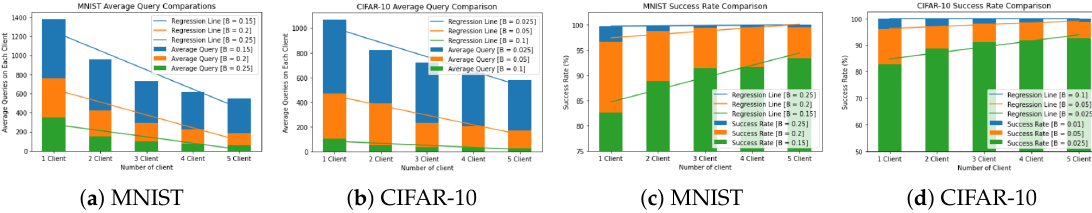
Figure 6. Distributed Approach and Constrained Boundary Evaluation. X -axis for all graphs are number of client. Y -axis for ( a ),( b ) are required average queries, while ( c ),( d ) are the success rate. For MNIST, the blue, orange, and green bars are the results when the constrained boundary is set to 0.25, 0.2, and 0.15, respectively. For CIFAR-10, the blue, orange, and green bars are the results when constrained boundary set to 0.1, 0.05, and 0.025, respectively. Using this distributed approach, the number of query can be suppressed, even to reach lower than 400 while maintaining 100% attack success rate (blue bars).